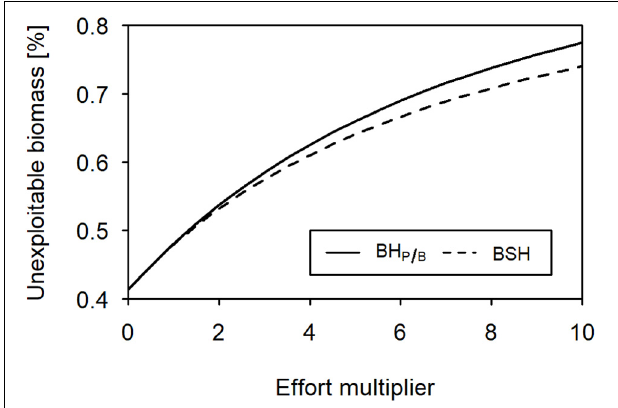
FIGURE 5 | Relative unexploitable biomass in the ecosystem (BH P / B , solid line; BSH, dashed line) under different levels of fishing